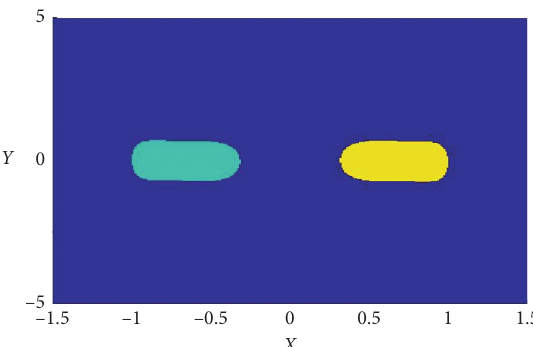
Figure 12: Cross section of the basins of attraction of the two coexisting attractors in the x - y -plane (Case B).